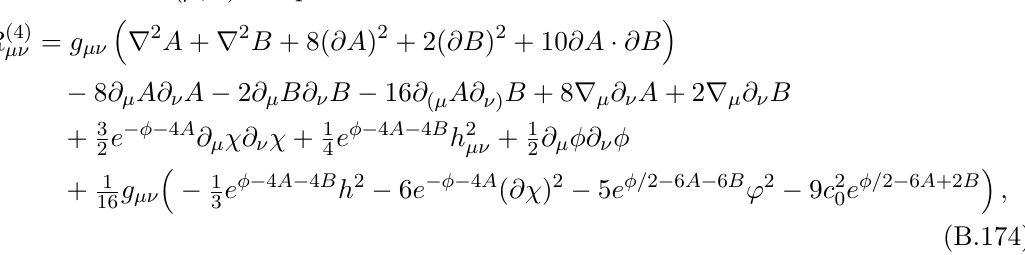
Figure 18 . Plot of ˙ ¨ S ( T ) , S ( T ) → 0